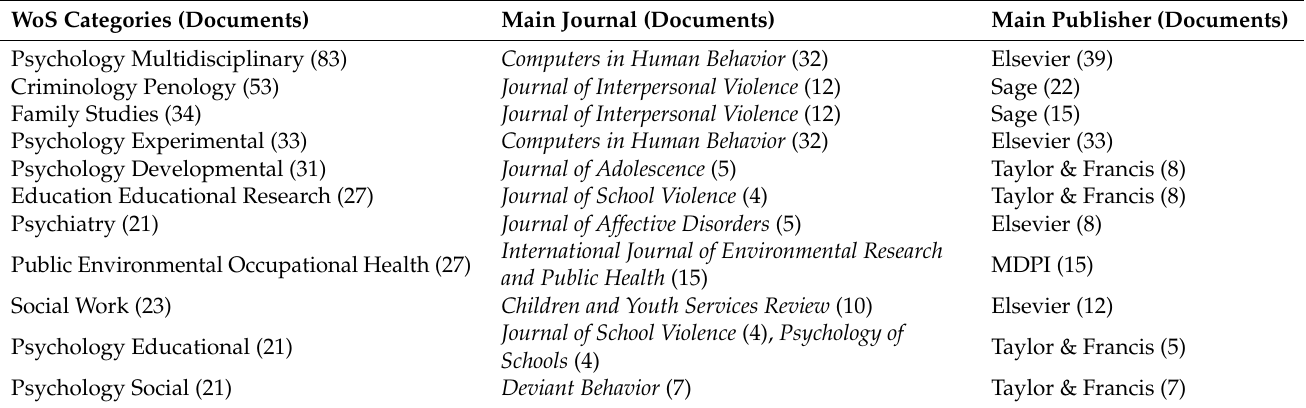
Table 1. Top 10 Web of Science (WoS) thematic categories according to the number of publications.